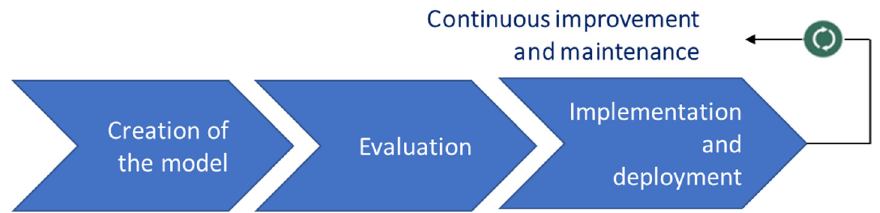
Figure 6. Methodology for the technological development of an AI Model. Source: own elaboration.